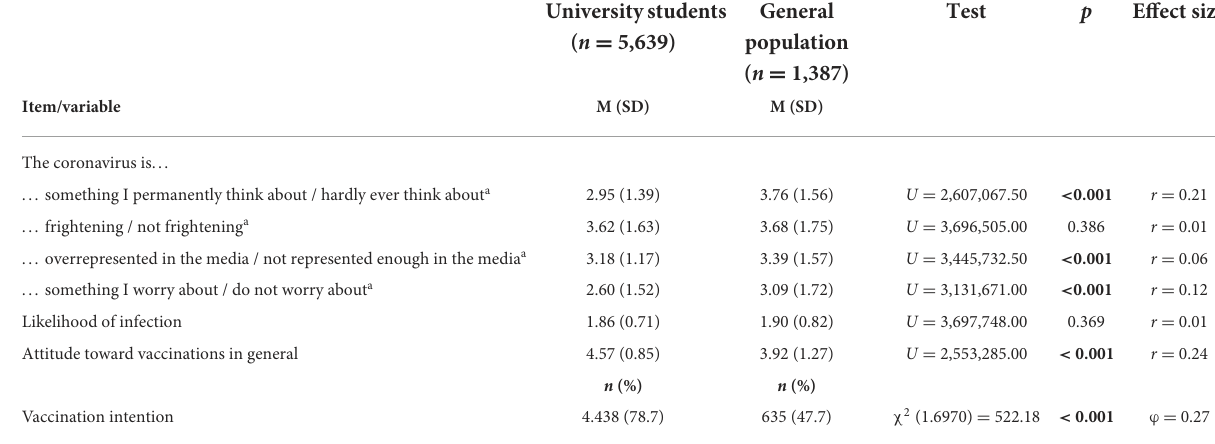
TABLE 3 Differences in attitudes toward the pandemic between university students and the general population.